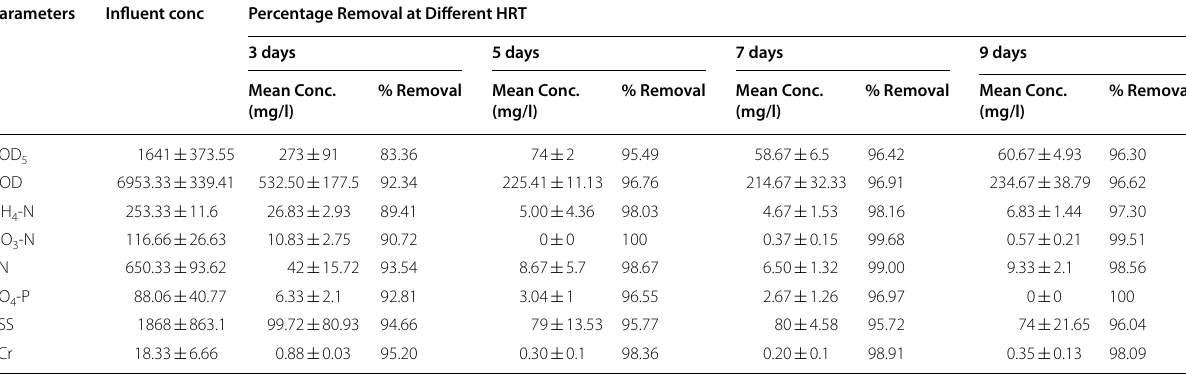
Table 3 Efficiency of HSSFCW with Pumice Substrate and CZ at Different HRT Parameters Influent